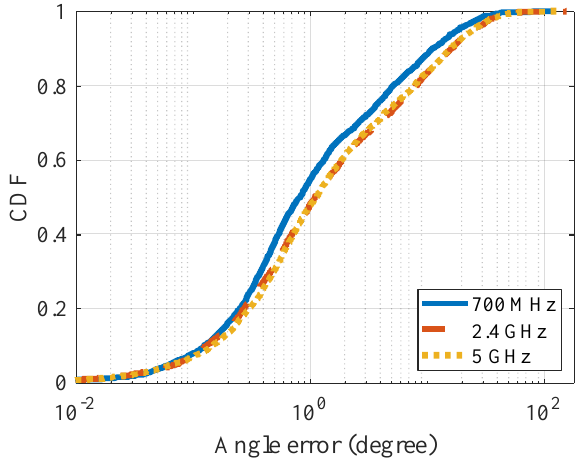
Figure 13. CDF of angle error for each frequency. Table 3. Average of angle error for each frequency band